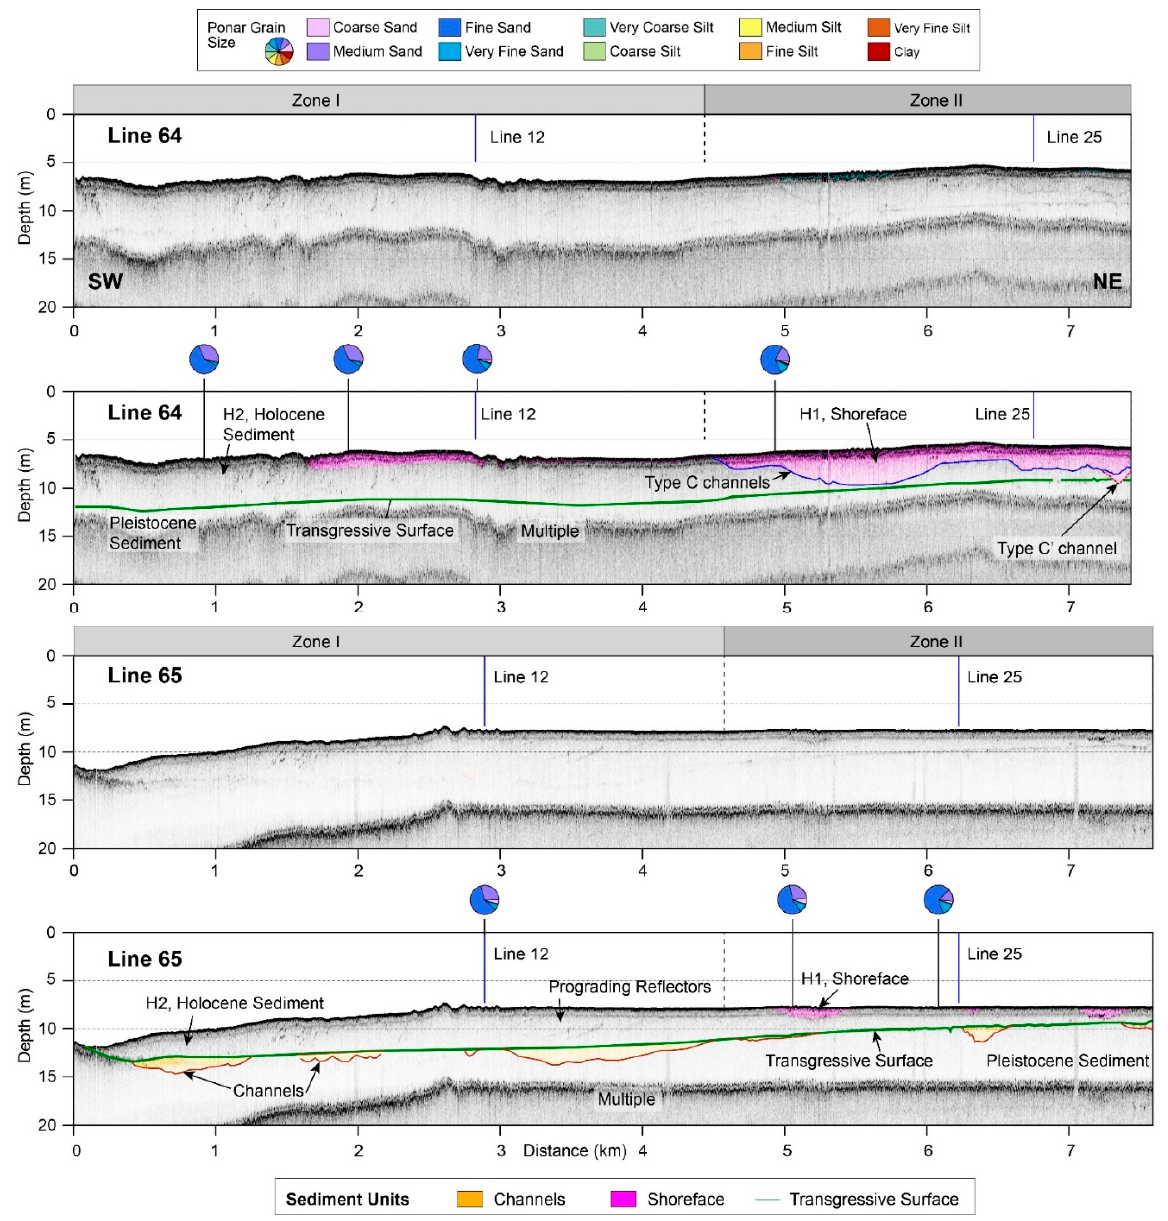
Figure 9. Nearshore strike profile 64 and seaward line 65 within the western geomorphic zones I and II highlight along-margin variability in depth of the regional unconformity and shoreface unit thickness. Solid black vertical lines show the location of surficial sediment grabs and grain size composition is shown by colored wedges. Blue vertical lines indicate intersecting dip profiles shown in Figure 8A,B. Profile locations are shown in Figure 1.